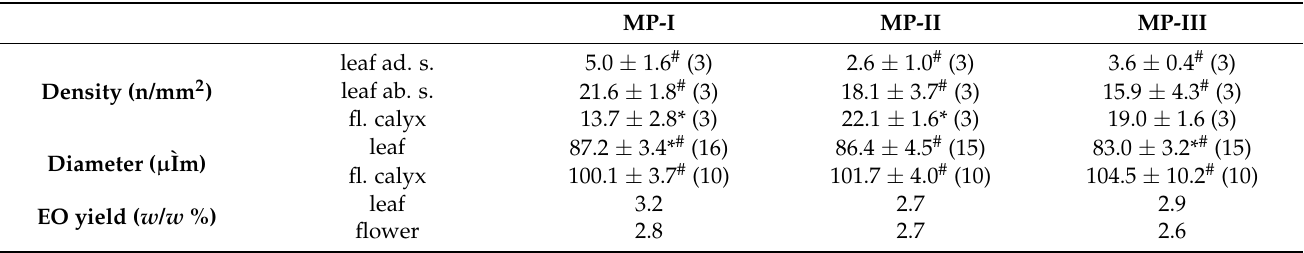
Table 1. Peltate trichome density and diameter, and essential oil (EO) yield, of the leaf and flower (calyx) of Mentha pulegium (MP), collected at three different locations in Sicily (MP-I, MP-II, and MP-III). MP-I MP-II MP-III leaf ad. s. Density (n/mm 2 ) leaf Diameter ( µ Ì m) EO yield ( w / w %) Data of peltate trichome density and diameter are expressed as mean ± S.D. ( n = 3). Asterisks (*) indicate groups significantly different from each other in horizontal comparisons ( p < 0.05), and hashes (#) in vertical comparisons ( p < 0.01). ad. s. = adaxial surface; ab. S = abaxial surface; fl. =